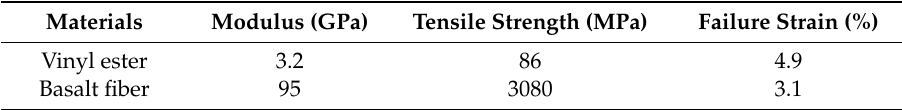
Table 1. The mechanical properties of the materials used in the polymer composites.